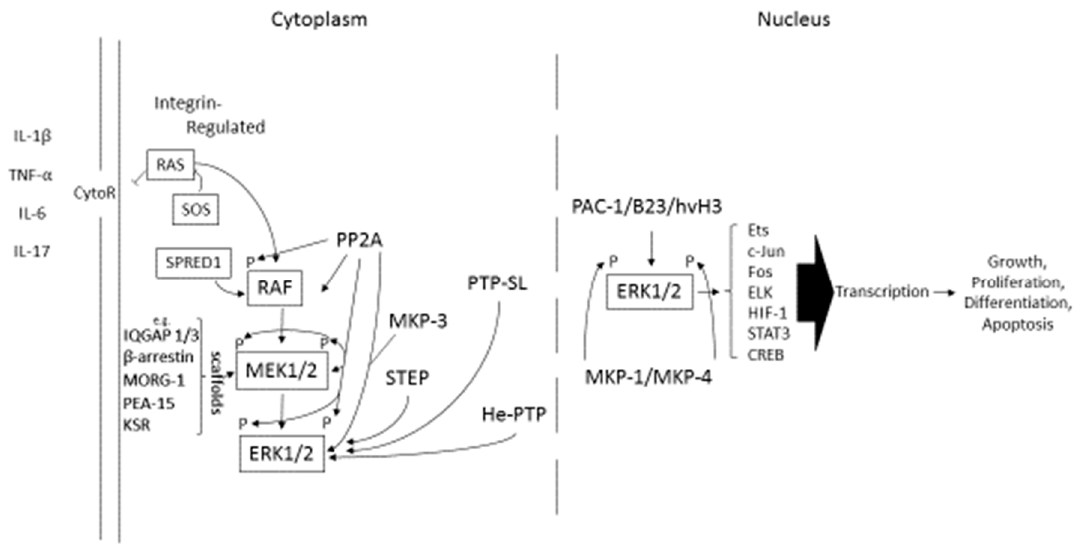
Figure 1. Activation and Regulation of the ERK1 / 2 Signaling Cascade. Pro-inflammatory cytokines are elevated in various states of chronic inflammation. These cytokines are exemplified by IL-1 β [20], TNF- α [20], IL-6 [21], and IL-17 [22]. They interact with their respective receptors (CytoR) on the plasma membrane of many cell types to initiate the ERK signaling cascade. Figure 1 was adapted from a figure produced by ABCAM, Inc. (www.abcam.com). Permission to publish this schematic was solicited and approved by ABCAM.com.